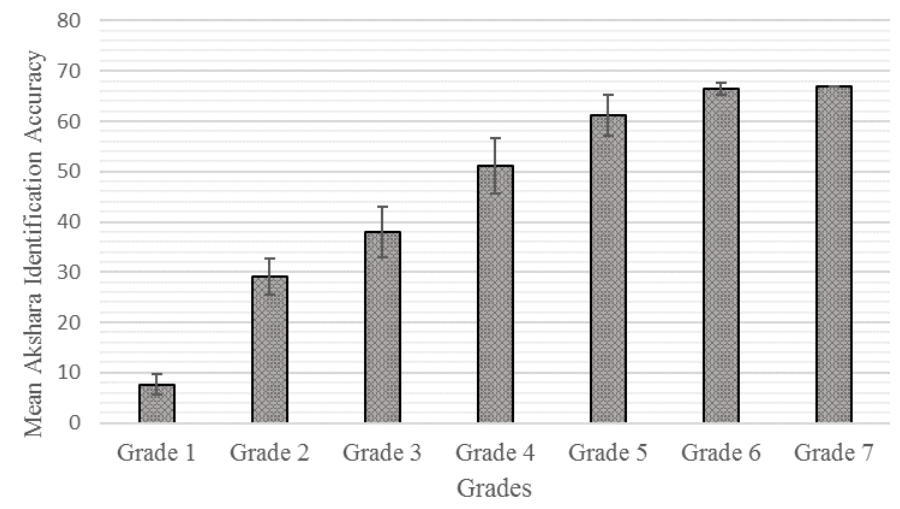
Figure 1. Mean and standard deviation for akshara identification accuracy from Grade I to Grade